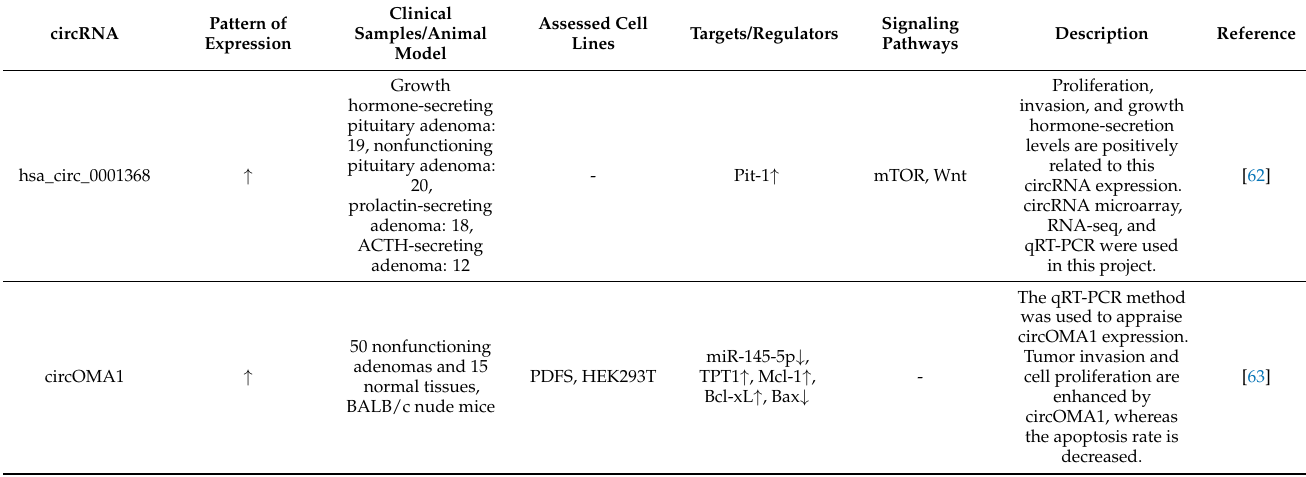
Table 3. circRNAs and pituitary gland tumors.